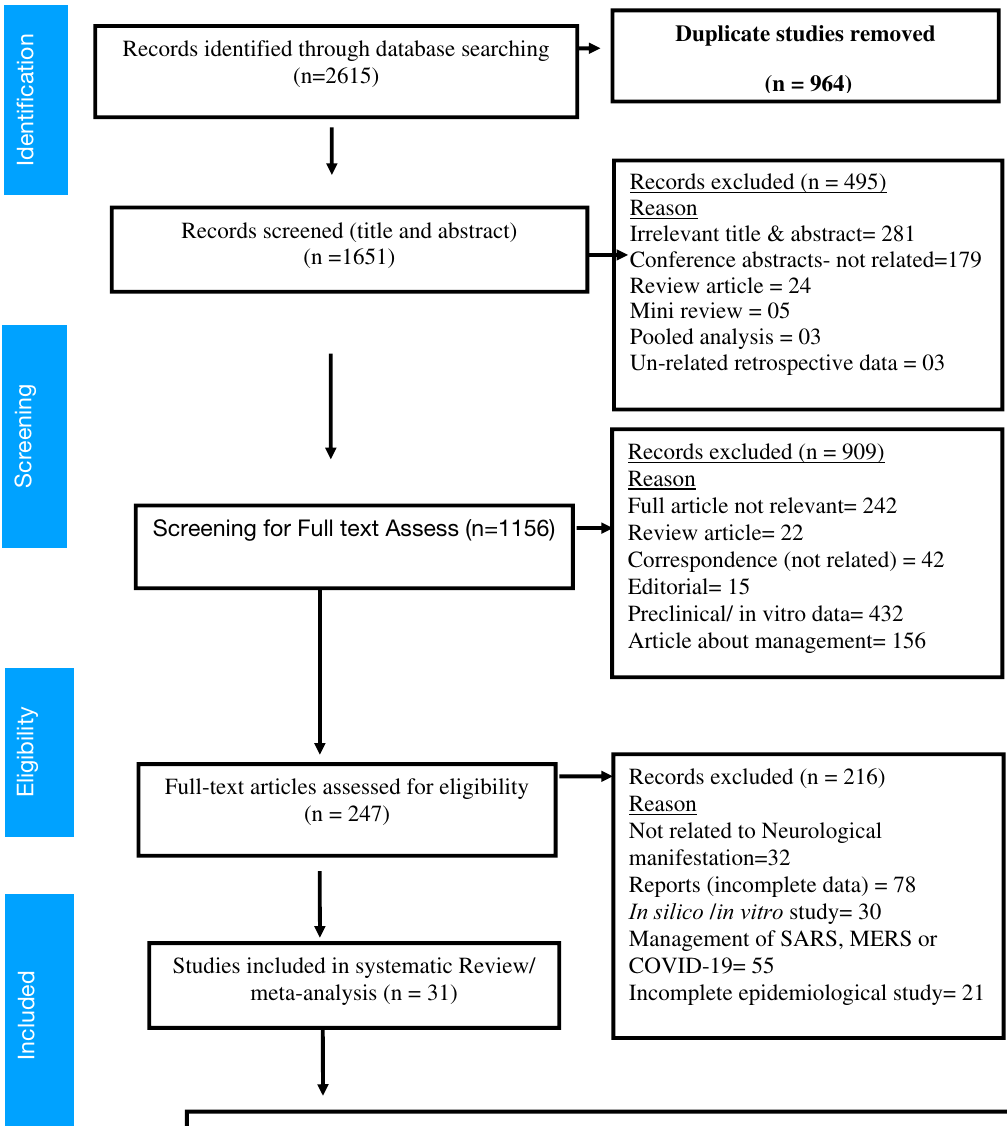
Figure 1. PRISMA chart 2,10–37 showing study section criteria and